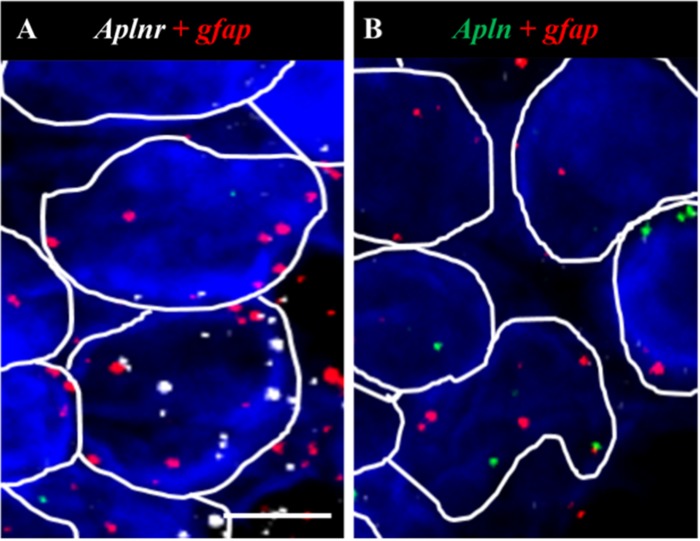
Aplnr and apln transcripts colocalise with gfap in the AP.(A, B) Representative fluorescent images showing colocalization of aplnr (white dots, A) and apln (green dots, B) with gfap (red) in the AP. Scale bar = 20μm. n = 4.